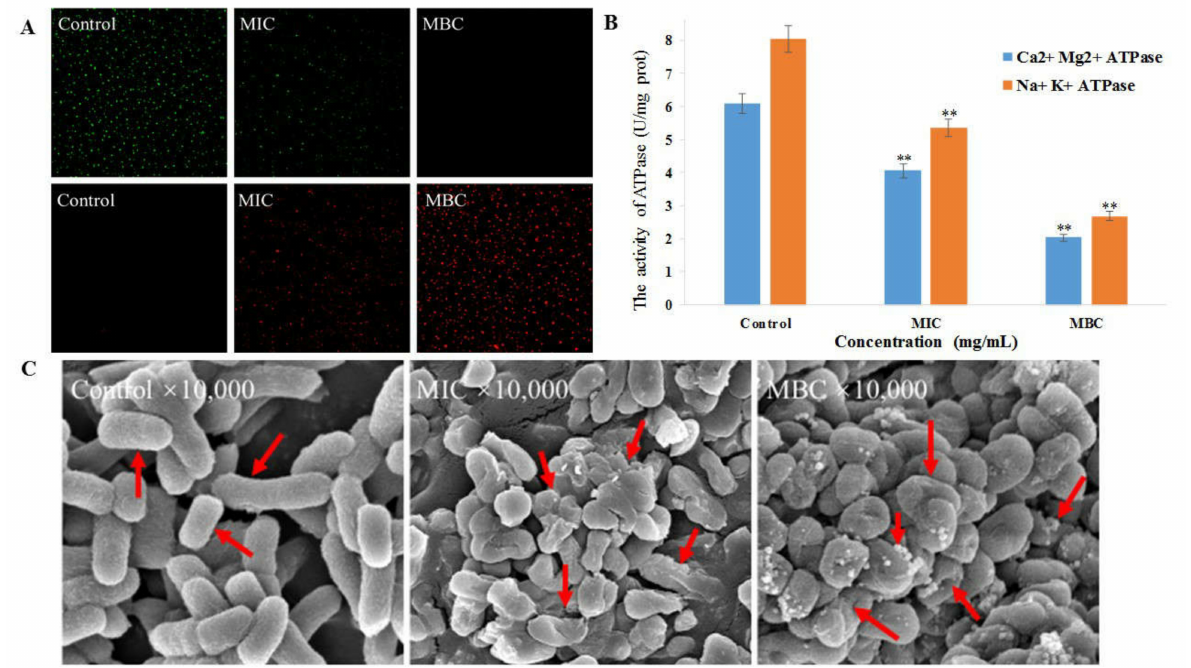
Figure 5. ( A ) CLSM images of S. flexneri cells stained with AO/EB. ( B ) The effect of Bacitracin-AgNCs on the activity of Ca 2+ Mg 2+ - and Na + K + -ATPase of S. flexneri . ( C ) FESEM images of S. flexneri following Bacitracin-AgNCs treatment. ** Statistically significant differences ( p <